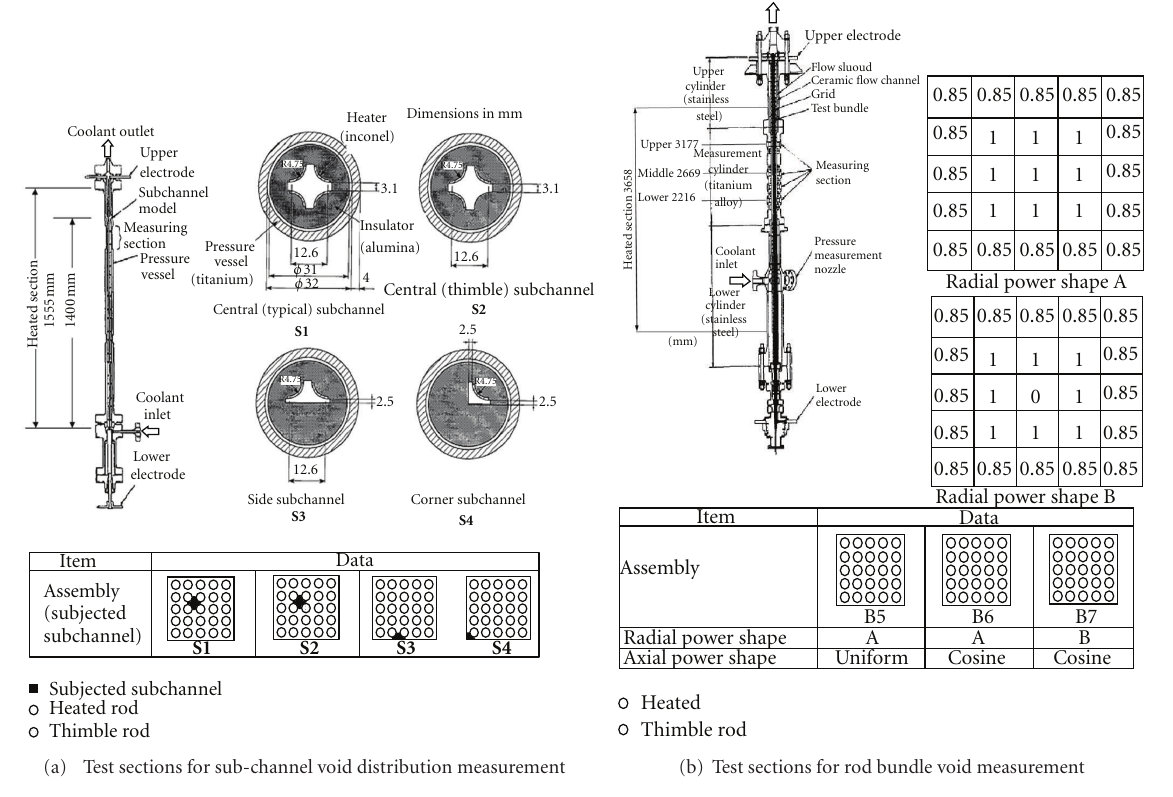
(b) Test sections for rod bundle void measurement Figure 1: Test sections of PWR subchannel and bundle tests.